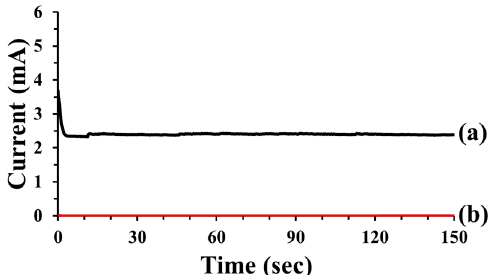
Figure 7. Current versus time for scratched control and self-healing coatings: ( a ) control coating; and ( b ) STP/DD-microcapsule-containing self-healing coating. After preparation of the coatings, scratching, healing and electrochemical tests were conducted at − 20 °C.